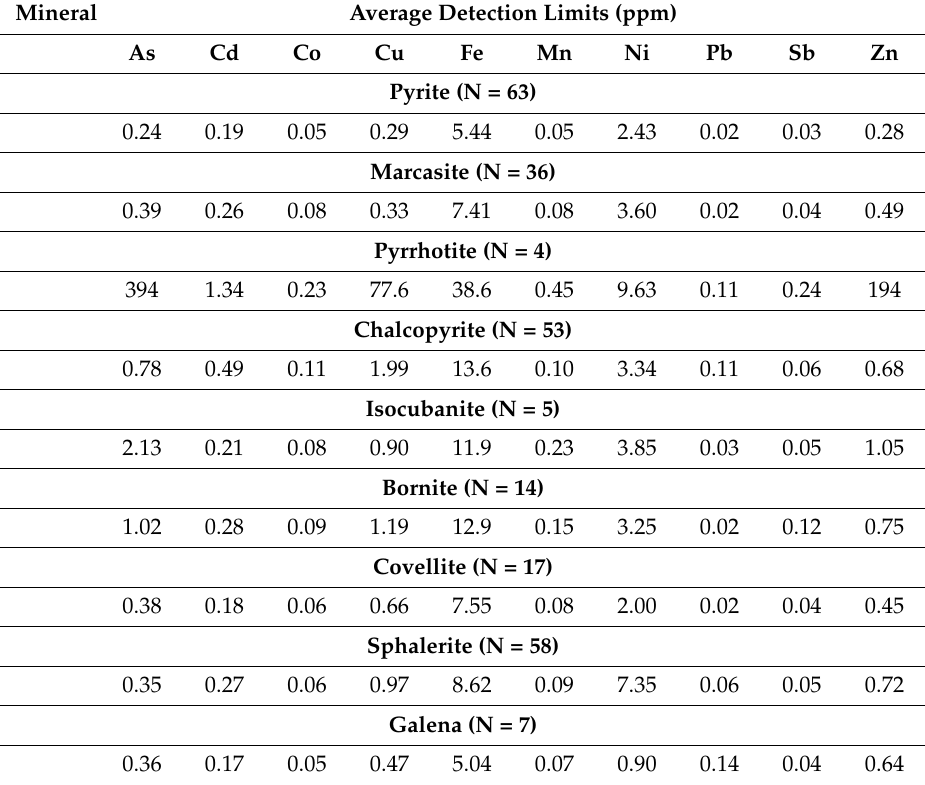
Table 3. LA-ICP-MS average detection limits (ppm) for selected elements (Fe, Cu, Zn, As, Pb, Sb, Cd, Co, Ni and Mn) in each mineral phase.